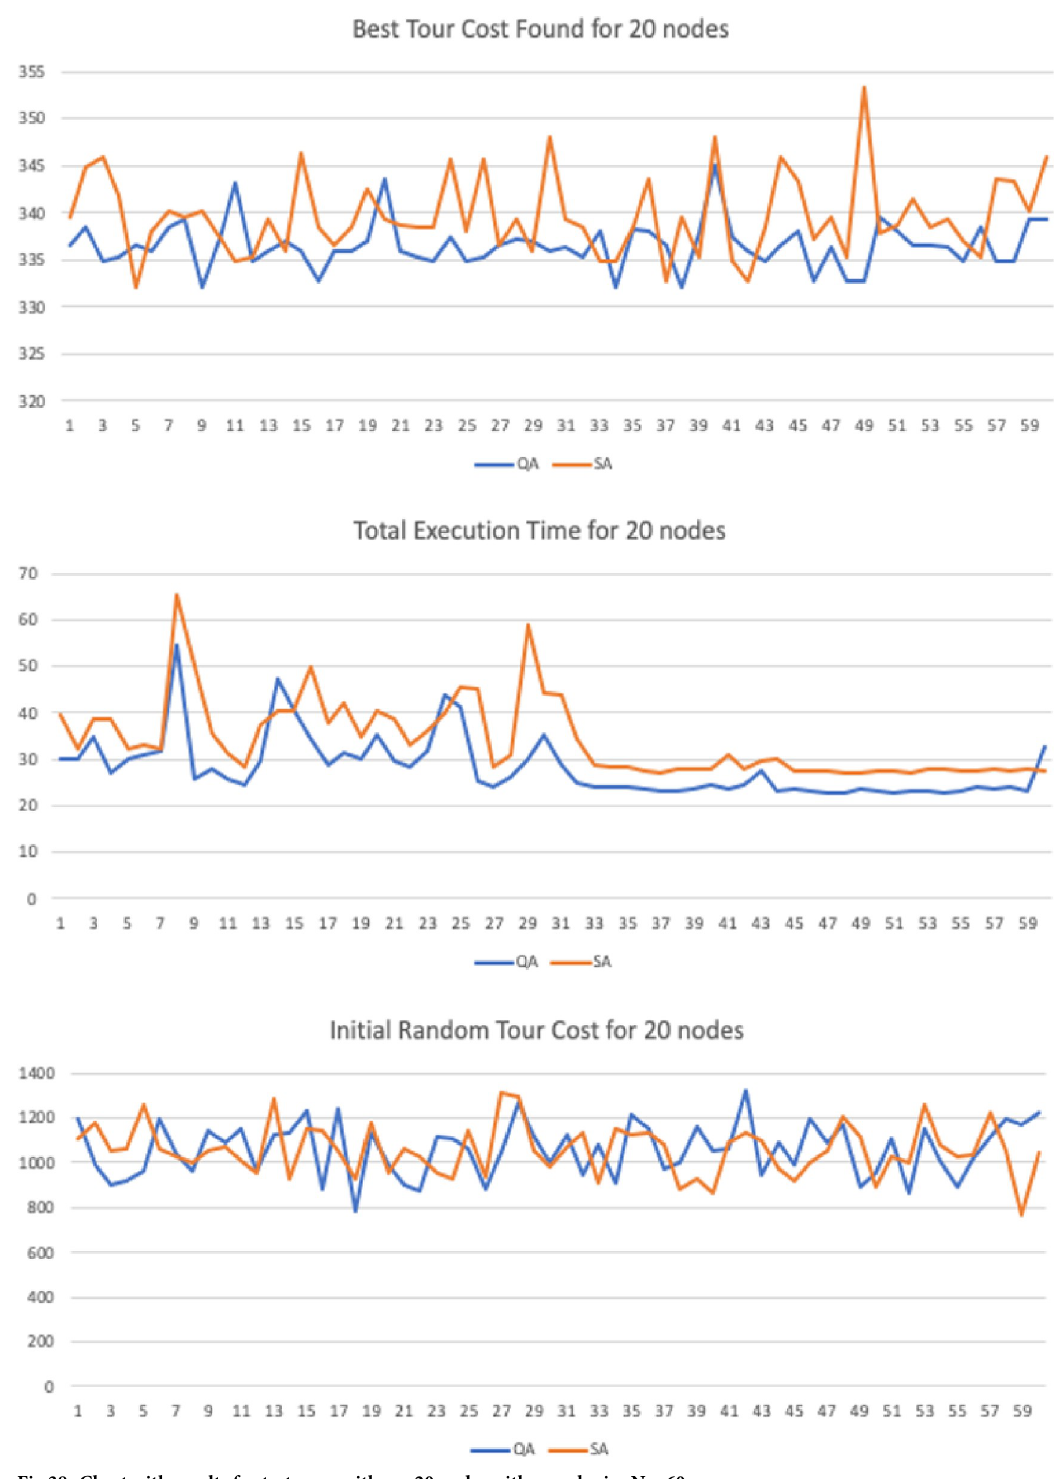
Fig 38. Chart with results for test cases with n = 20 nodes with sample size N = 60.